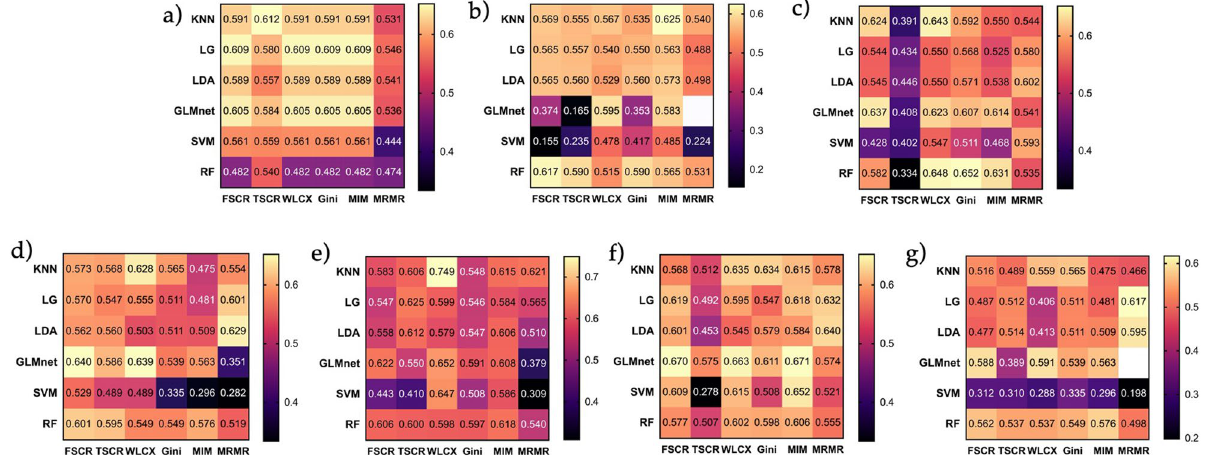
Figure 3. Heatmaps summarizing areas under the ROC curve (AUC) of predictive models developed including ( a ) clinicopathological predictors alone, ( b ) T2WI-derived radiomic features alone, ( c ) ADC-derived radiomic features alone, ( d ) a combination of clinicopathological predictors, T2WI-, and ADC-derived radiomic features, ( e ) a combination of clinicopathological predictors and T2WI-derived radiomic features, ( f ) a combination clinicopathological predictors and ADC-derived radiomic features, and ( g ) a combination of T2WI- and ADC-derived radiomic features. Each cell presents an AUC for a model developed using a given combination of feature selection and machine learning algorithms. 95% confidence intervals for each model are summarised in Supplementary Tables S1-7, respectively. Blank cells ( b , g ) denote models shrunk to the intercept only due to the regularisation approach used by